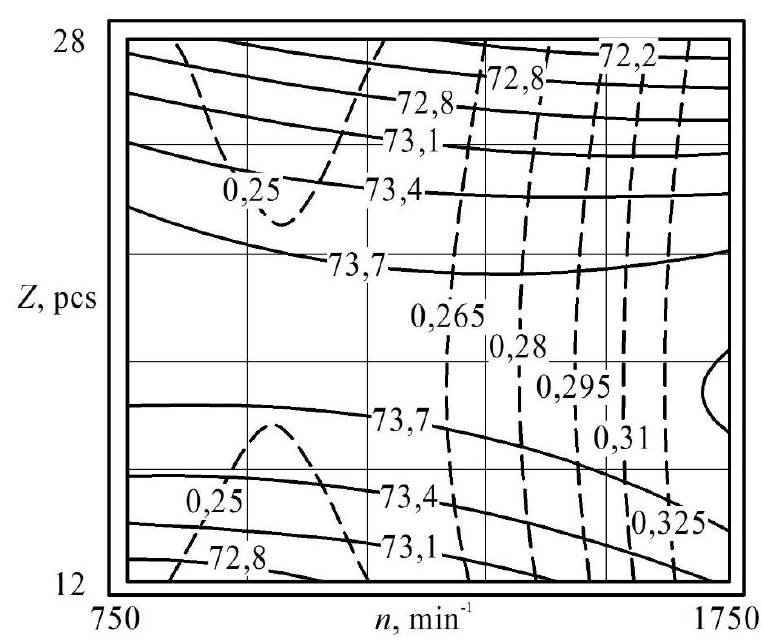
Figure 11. Two-dimensional section of the response surface of the degree of homogeneity (——–) and the consumption of electrical energy (- - - - -) from the number of blades and the frequency of rotation of the impeller shaft.